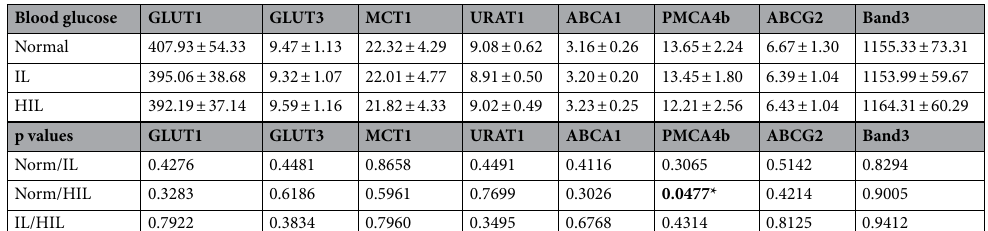
Table 4. Results of Mann–Whitney analysis of membrane protein expression values in the combined groups of controls and T2DM patients, divided into normal (n = 72, except for MCT1, n = 61), increased level (IL—n = 30, except for MCT1, n = 28) and highly increased level (HIL—n = 18, except for MCT1, n = 15) groups, based on blood glucose levels.